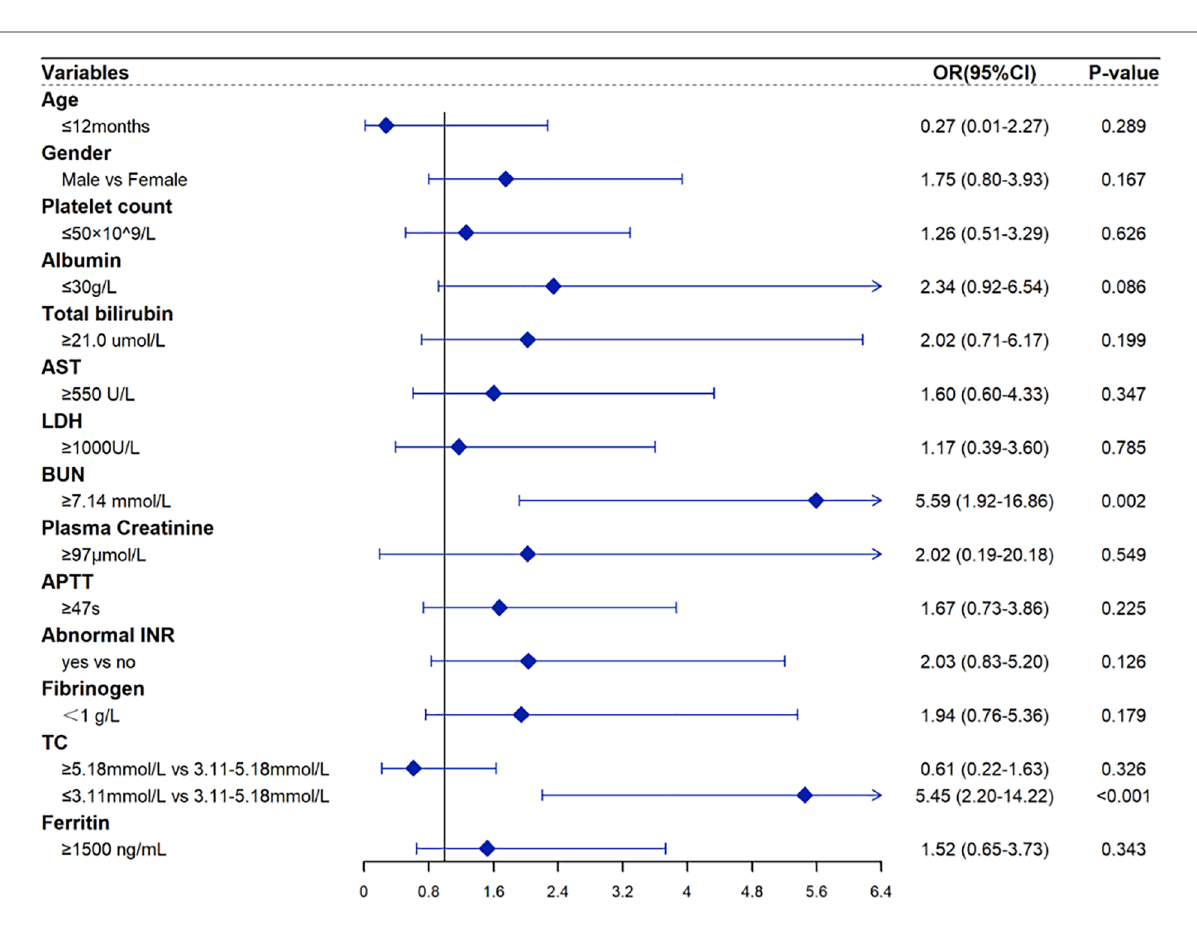
FIGURE 7 Forest plots for the multivariate logistic regression analysis with only complete HLH